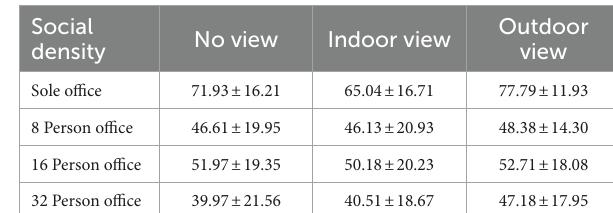
TABLE 2 Mean and standard deviations of questionnaire responses concerning personal space satisfaction (scored 0–100) across view type and social density for the Korean participants.